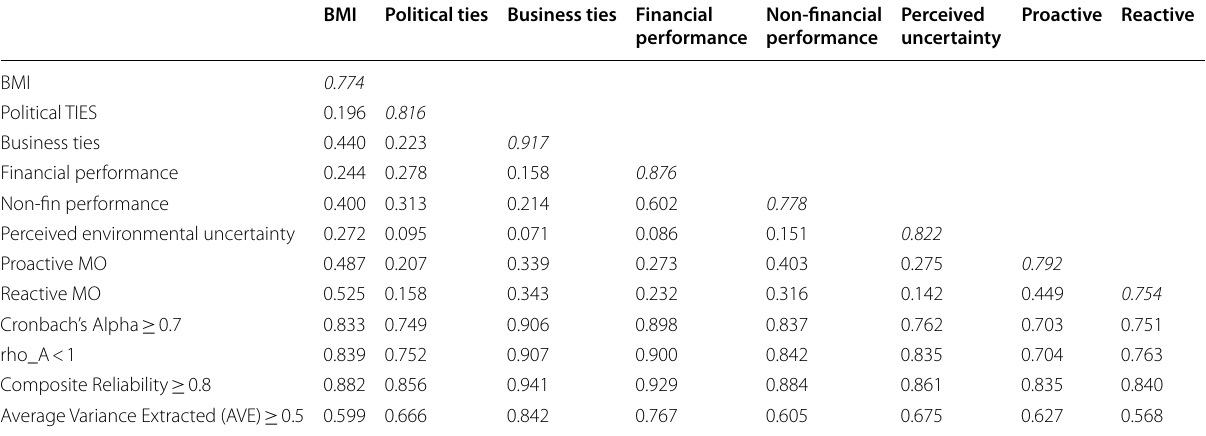
Table 1 Latent variables correlation, reliability and validity